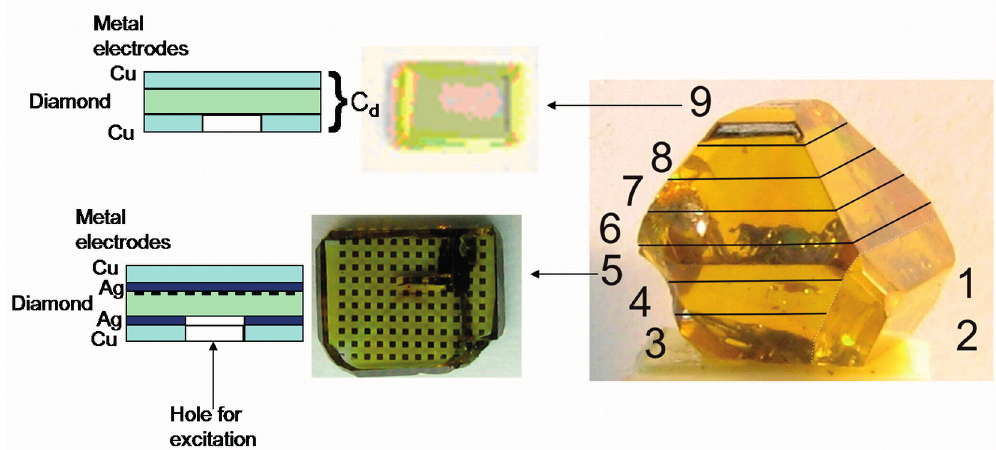
Figure 1. A sketch of slicing of the HPHT diamond crystal and a picture of the micro-pixel (isle type) contacts deposited on the wafer sample No. 5. The cross-sections of the capacitor type sensors made of diamond wafers covered by metallic electrodes are also shown in the